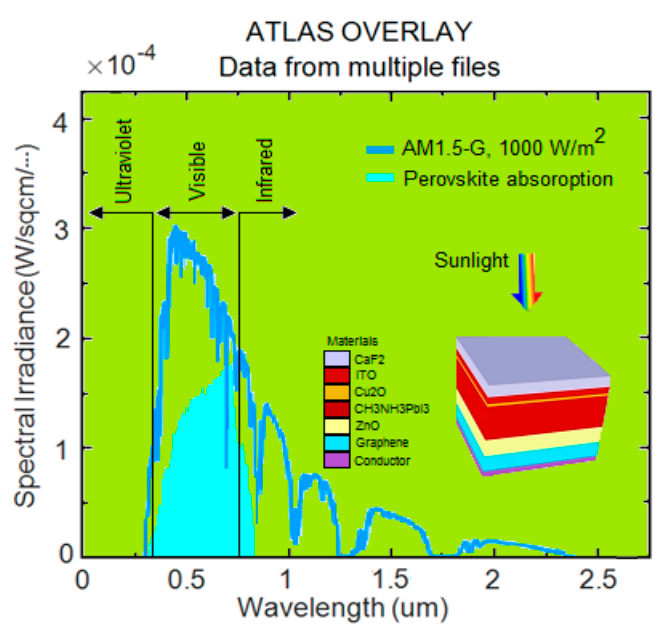
Figure 8. AM 1.5 G standard spectrum used in the simulation.